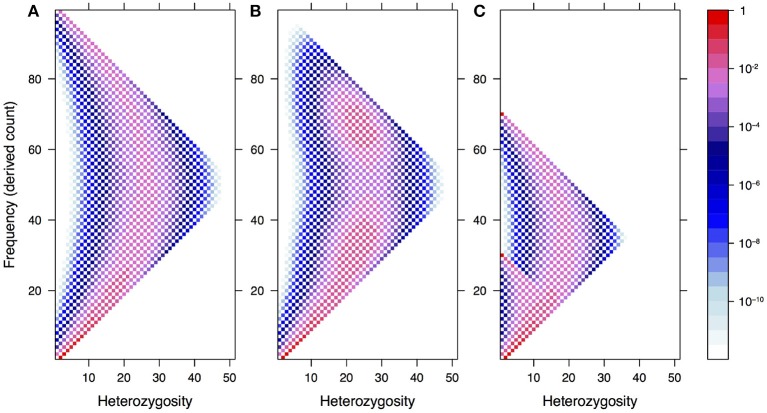
The expected frequency-heterozygosity spectrum for a locus with θ = 1 in a sample of size n = 100 from a single population of constant size (A) and under two demographic models: recent admixture (B) and population structure (C). In both cases, we assume two well-separated populations with divergence equal to θ, the effective population size of the first population being twice the size of the other. In the former case, we assume instantaneous admixture of the two populations and random mating thereafter. In the latter case, the consequence of the absence of mating between different populations is a reduction of heterozygotes in the pooled population, known as the Wahlund effect.